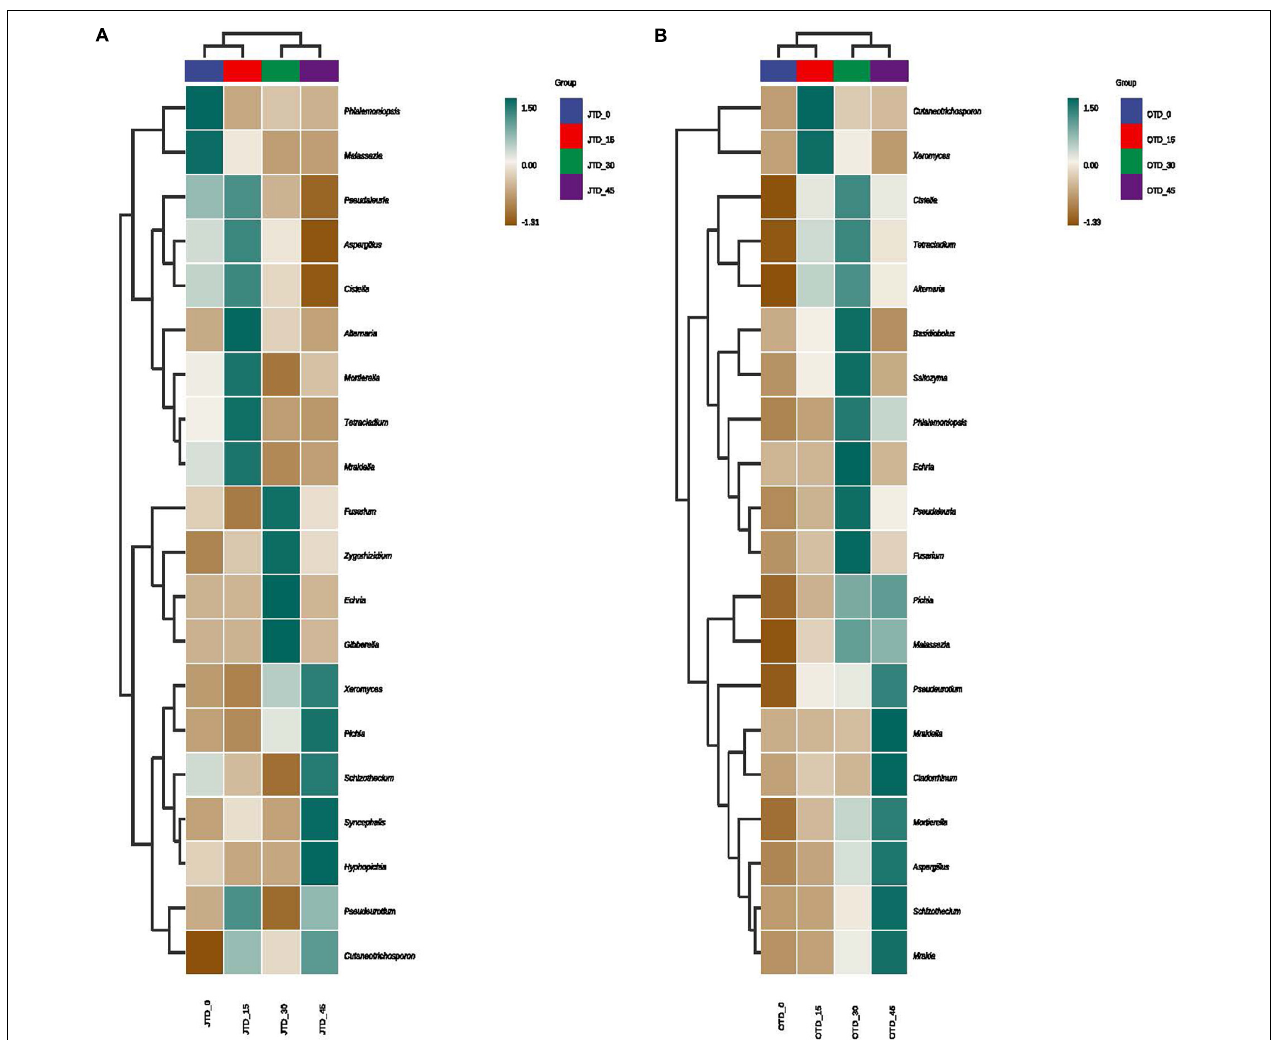
FIGURE 4 | Hierarchical clustering analysis of fungal communities under different protein content diets treatments in July (A) and October (B)